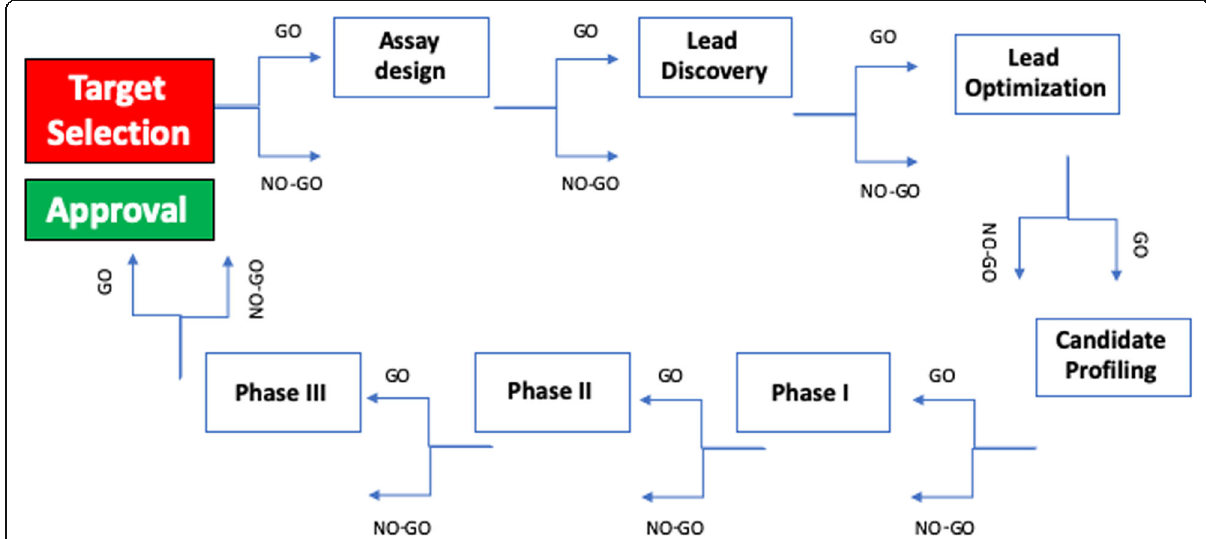
Fig. 3 Stage-gate decision process in drug discovery and development. Go/no-go decision making process along milestones such as those indicated above used in biopharmaceutical industry during drug discovery and development process. As in preclinical and clinical development, go / no-go decision setpoints are defined for each milestone according to the target product profile that must be fulfilled to continue drug discovery and development process. Discovery and development research is also covered by benchmark initiatives which provide average risk/ success rates, timelines, and resources used per milestone. Adapted from